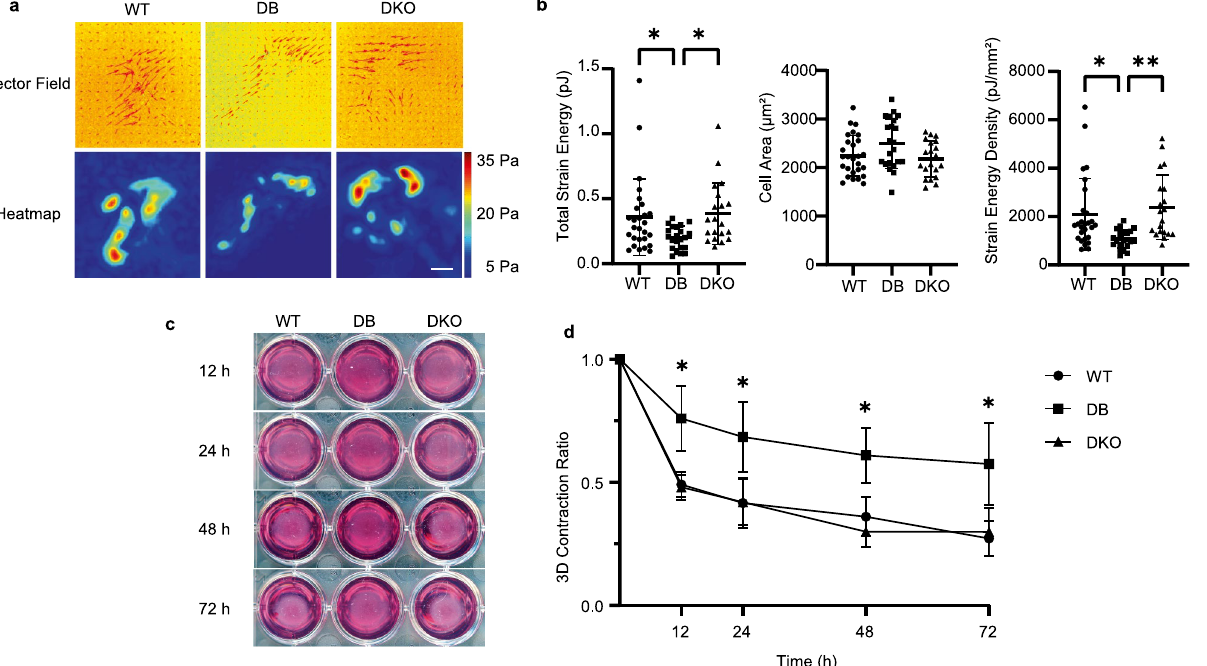
Figure 3. Diabetic fibroblasts generate less force on 2D and 3D collagen matrix. ( a ) Top, representative vector fields of WT, DB, and DKO fibroblasts seeded on 12 kPa polyacrylamide gels show the underlying beads displacement. Bottom, corresponding heatmaps of traction force show the magnitude and distribution of stress. Scale bar = 40 μm. ( b ) Left, measurements of total strain energy for each group show the lack of strain energy in DB cells. Middle, cell area measurements show no differences among the groups. Right, strain energy density measurements show the lack of force generation per unit area in DB fibroblast (n animals = 3 per genotype, n cells ≥ 20 per animal). One-way ANOVA followed by Tukey’s post hoc test and multiple comparison test. **p < 0.01, *p < 0.05. ( c ) Representative images of 3D collagen gel contraction over 72 h show impaired 3D contraction of DB fibroblasts. ( d ) Contraction ratios measured over 72 h show significant contraction among WT and DKO compared to DB fibroblasts. Contraction ratios were calculated by dividing gel size by the starting size. Data were collected by averaging 3 gels per group (n animals ≥ 4 per genotype). Two-way ANOVA using Mixed-effects model with Geisser-Greenhouse correction followed by Sidak’s multiple comparison test. *p <